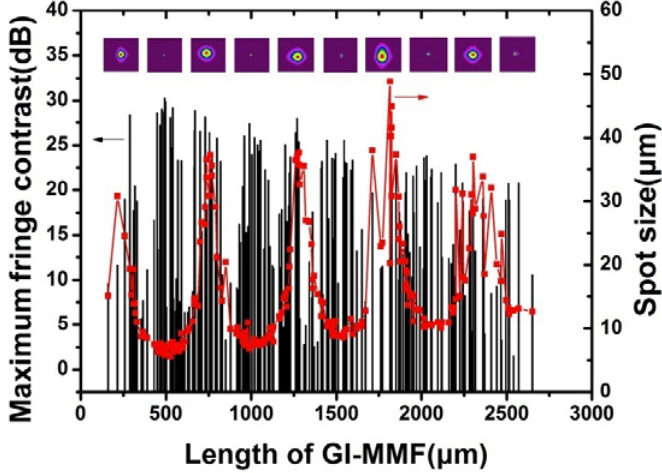
Figure 4. Spot sizes of 212 sensors with different GI-MMF lengths (the red line) and relationship between maximum fringe contrasts and GI-MMF lengths (the black